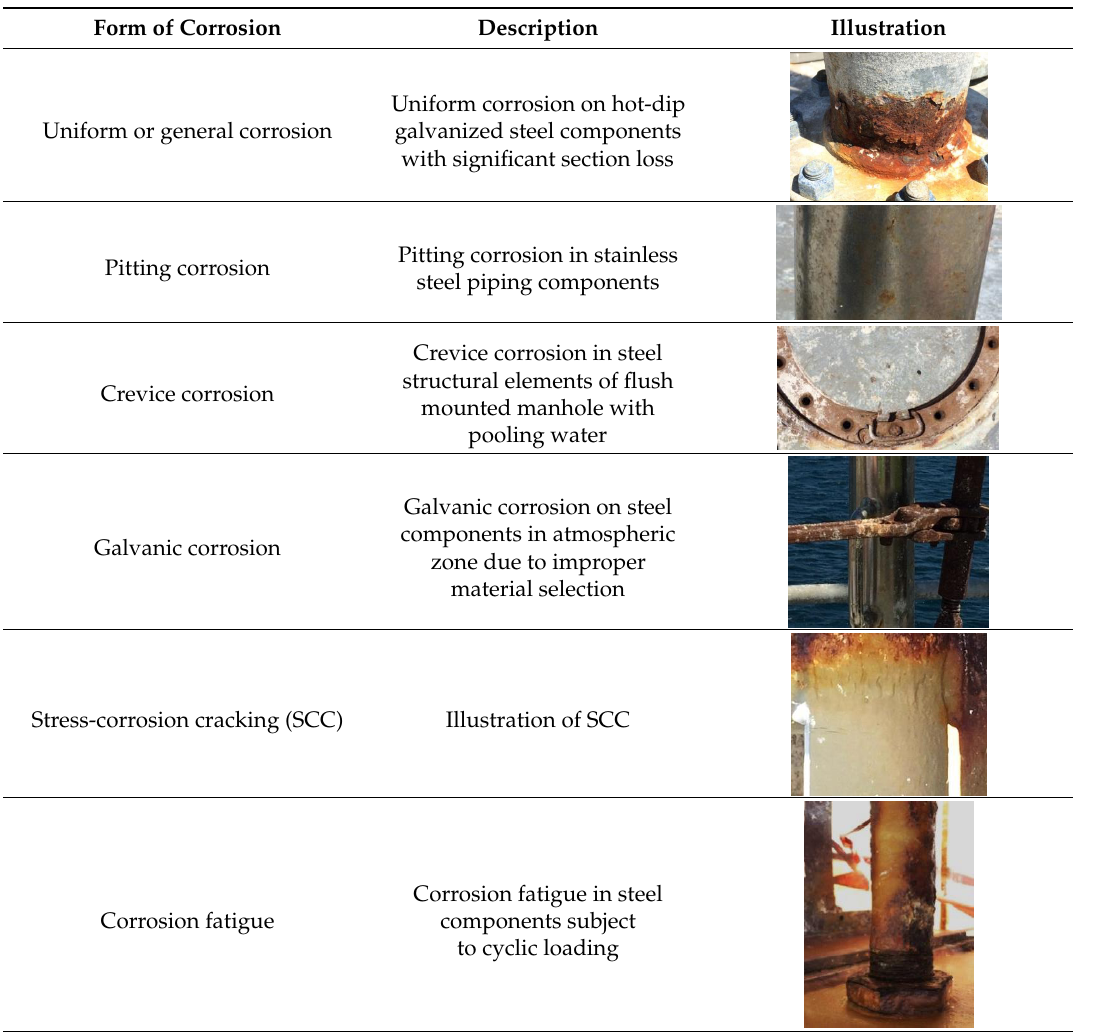
Table 3. Examples of typical forms of corrosion that occur in marine environment on metallic elements and structural components of